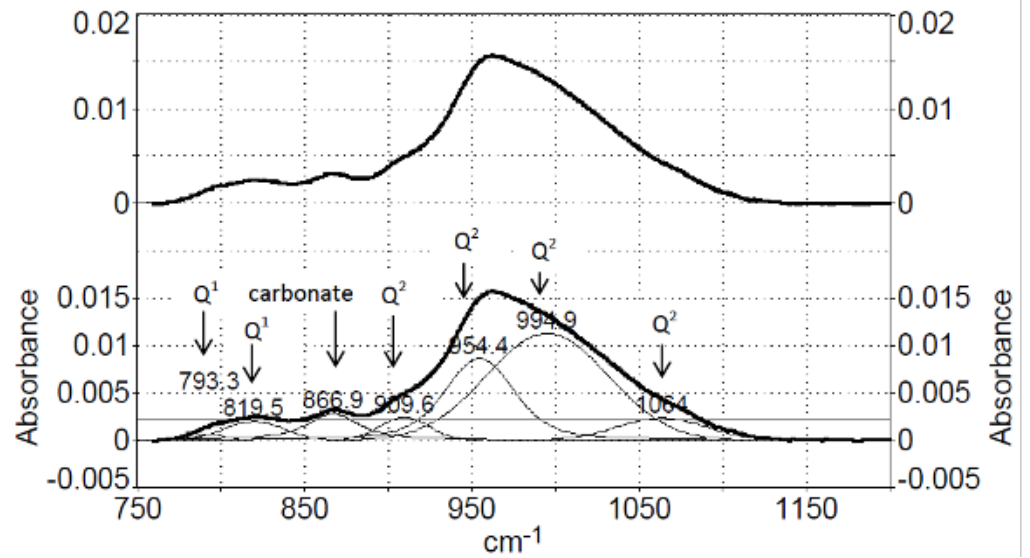
Figure 2. ATR IR spectrum of fully hydrated activated alite with age 6 months in the range of the most important bands of C-S-H including the peak fit. Background (logarithm function) subtracted before, leaned on the minima at the end of the displayed range. Note that the signal of the Q 1 structural element seems to be more sharp and restricted to lower wave numbers than in the case of a commercial cement stone (see Figure 3).